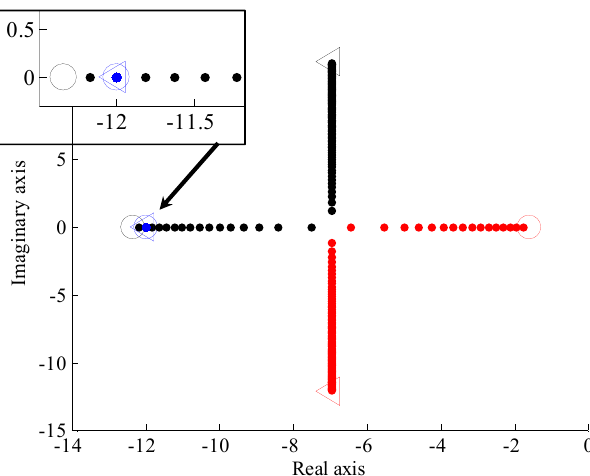
Figure 15. Location of the poles for the assistive toilet system for a gain loop K p varying from 1 (circle) to 100 (triangle), c v = 120 Ns/m, T = 0.08 s, m v = 10.